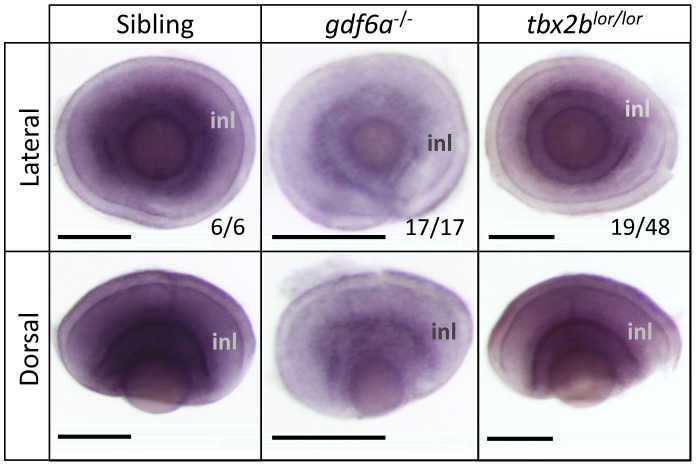

gdf6a positively modulates the abundance of tbx2b transcript during stages of retinal development when photoreceptors differentiate.All panels show in situ hybridization using tbx2b riboprobe. gdf6as327/s327 mutants have less tbx2b expression at 3 days post-fertilization (dpf) compared to normophthalmic siblings, akin to tbx2blor/lor mutants. Fractions represent proportion of clutch represented by image shown. Scale bars 100 μm; inl, inner nuclear layer.